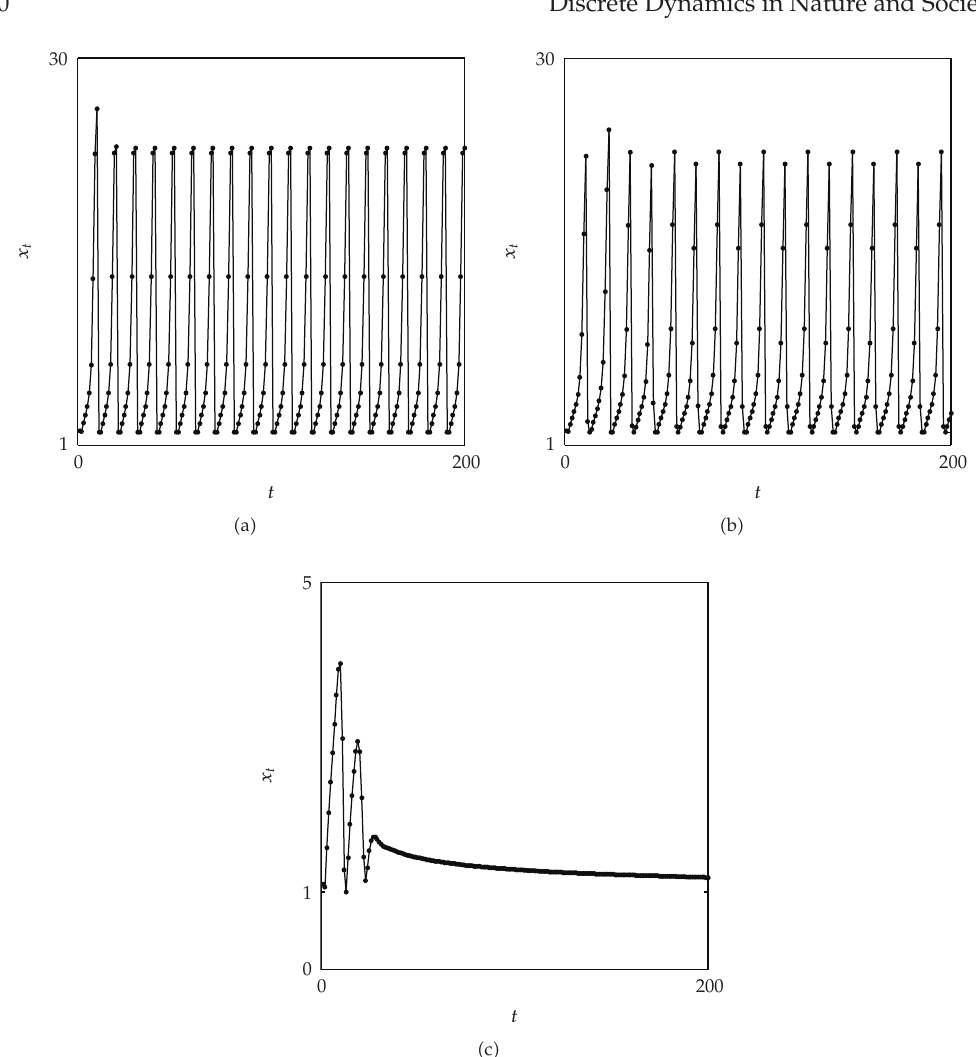
Figure 4: State variable x t versus time for the initial condition x 0 (cid:9) 1 . 1, m 0 (cid:9) 0 . 8 and w 0 (cid:9) 0 . 8 and parameter values α (cid:9) 1, λ (cid:9) 1, σ 2 (cid:9) 1, r (cid:9) 0 . 02, C (cid:9) 0 . 5, β (cid:9) 1. In panel (cid:2) a (cid:3) a (cid:9) 0 . 35, in panel (cid:2) b (cid:3) a (cid:9) 0 . 4, in panel (cid:2) c (cid:3) a (cid:9) 0 .